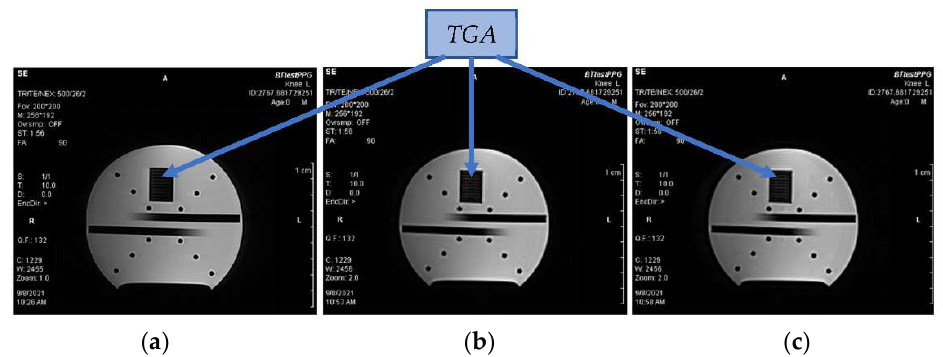
Figure 14. MR images of the water phantom with the testing grid area obtained in three BT commu-